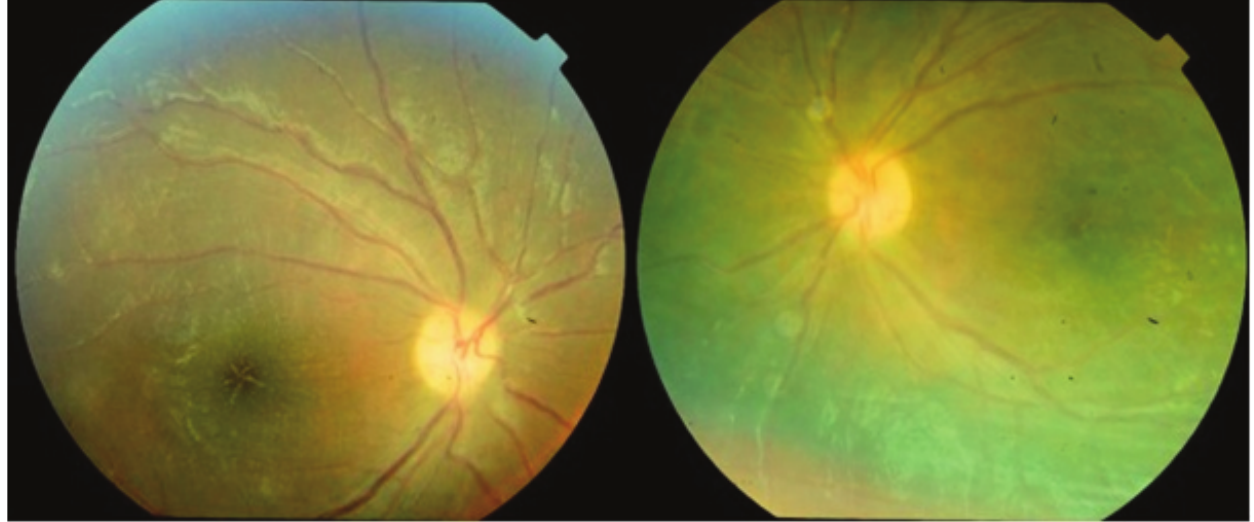
Figure 3. At the end of the 2 nd week of treatment, complete resolution of the vascular sheathing and exudates is observed. Note the pigmentary macular change in both eyes.